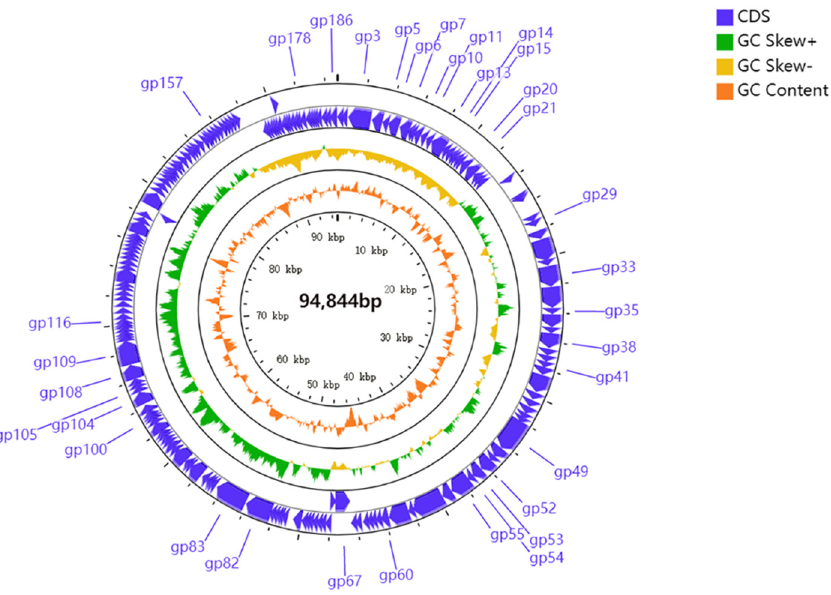
Figure 5. Genomic map of PHB09. Circles from outermost to innermost correspond to predicted genes (BLASTp, nr database, E value of <0.00001) on forward strand; reverse strand; GC content. Proteomic tree of PHB09 was generated based on genomic similarity scores (denoted by SG) derived from tBLASTx scores (Figure 6a). The viral proteomic tree revealed that phage PHB09 has a high sequence identity to Pseudomonas phage VCM, belonging to genus Otagovirus (query coverage 37%; identity 78.75%; accession number LN887844.1), and to Pseudomonas phage vB_PsyM_KIL5, belonging to genus Flaumdravirus (query coverage 51%; identity 88.29%; accession number KU130130.1) (Figure 6b). The whole genome of PHB09 was colinear with those two Psa phage genomes, with low similarity in terms of genomic architecture (Figure 7). The heatmap results were similar to the NCBI search results based on the complete genome of phage PHB09, indicating that phage PHB09 has low genomic similarity to known phages (Figure 8). The Bacterial and Archaeal Viruses Subcommittee [54] defines a genus as a cohesive group of viruses sharing a high degree of nucleotide identity (>50%) and being distinct from viruses in other genera. Thus, phage PHB09 might be classified as belonging to a novel